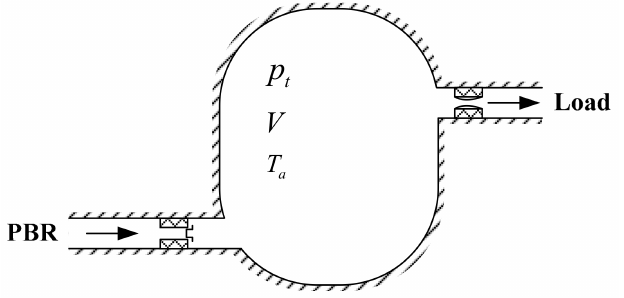
Figure 3. Pressure response model of